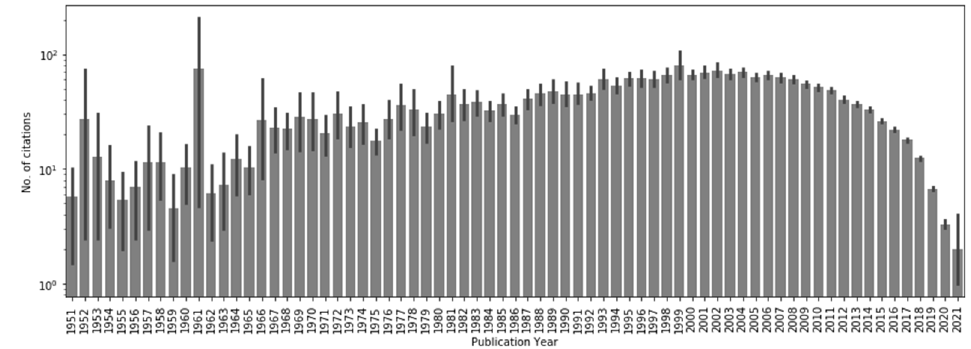
Figure 2. Distribution of citations for the manuscripts in the present corpus. Values are shown as mean +/ − standard deviation.